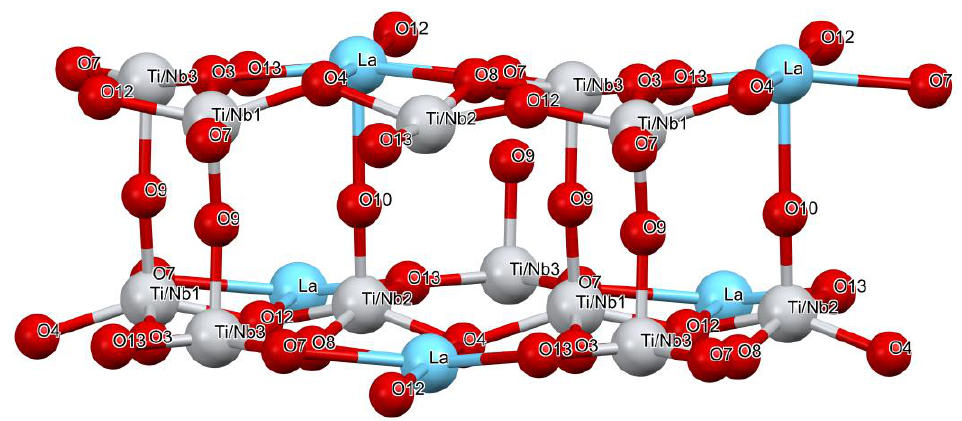
Figure 6. Connection of two adjacent layers of the first type by the oxygen bridges—ball and stick model with atom